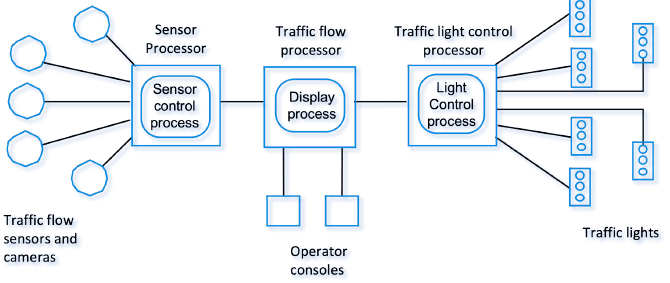
Figure 2. A multiprocessor traffic control system.